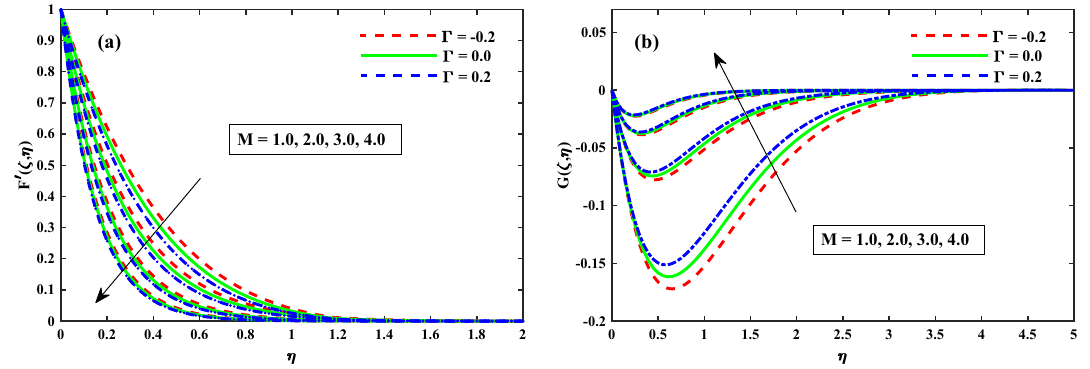
Figure 4. Impact of M on F ′ (ζ , η) in x-direction, and G (ζ , η) in y-direction at ζ